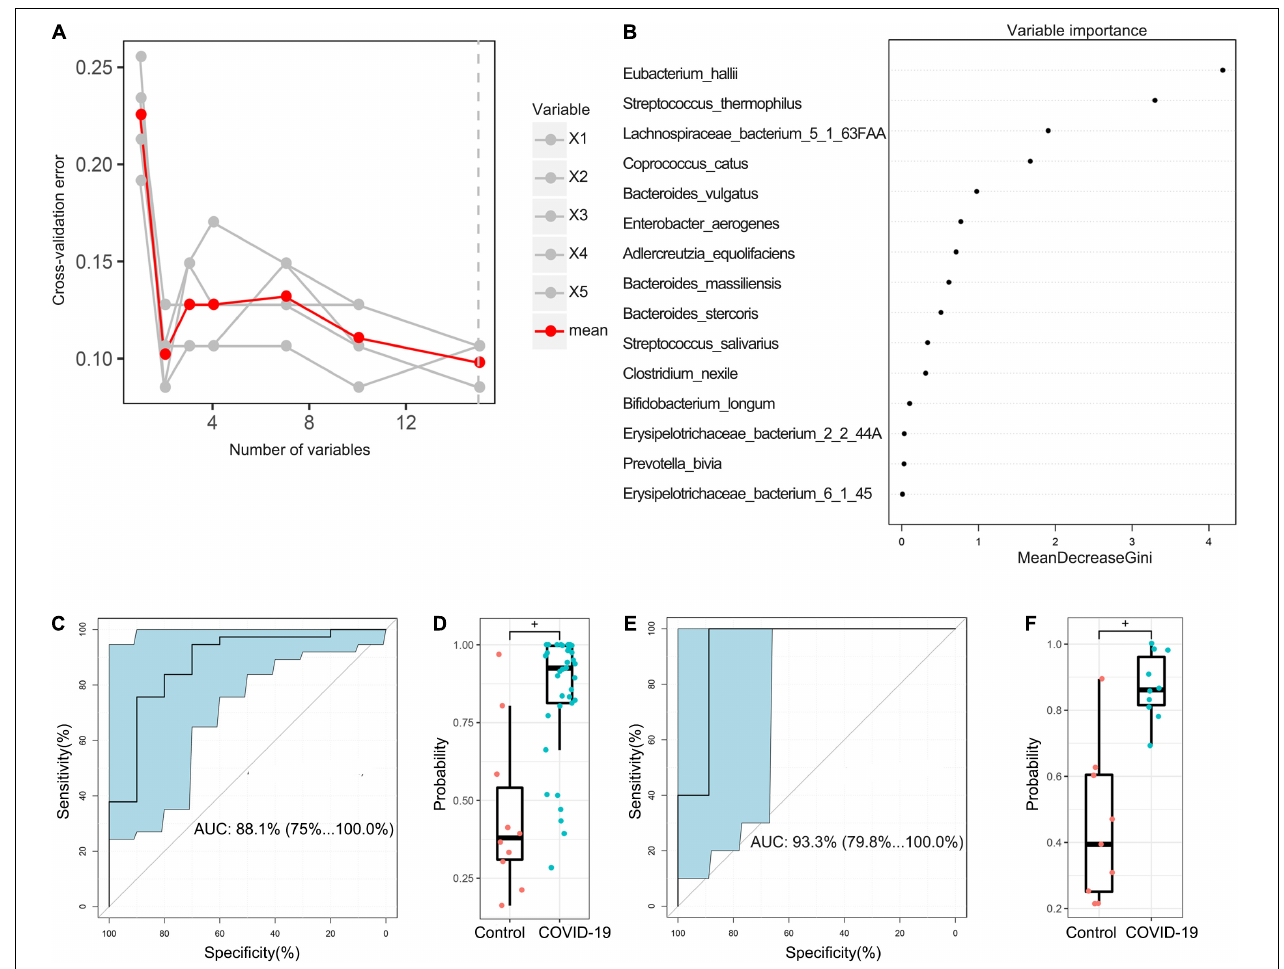
FIGURE 5 | Diagnostic potential of gut microbial markers in COVID-19 patients. (A) A total of 15 microbial markers were selected as the optimal markers set by the random forest (RF) model. The cross-validation error curve was plotted based on 15 significant species. (B) Variable importance measured by mean decrease in accuracy of the 15 predictor species in the RF model. (C) ROC and AUC were calculated based on a test set of the discovery cohort. The AUC was 88.1% with 95% confidence interval (CI) of 75.1–100.0% between COVID-19 patients and healthy controls ( p < 0.001). (D) Boxplot of probability in the discovery cohort. + P < 0.01. (E) The AUC value in the validation cohort was 93.3% with a 95% CI of 75.1–100.0% between COVID-19 and healthy controls. (F) Boxplot of probability in validation